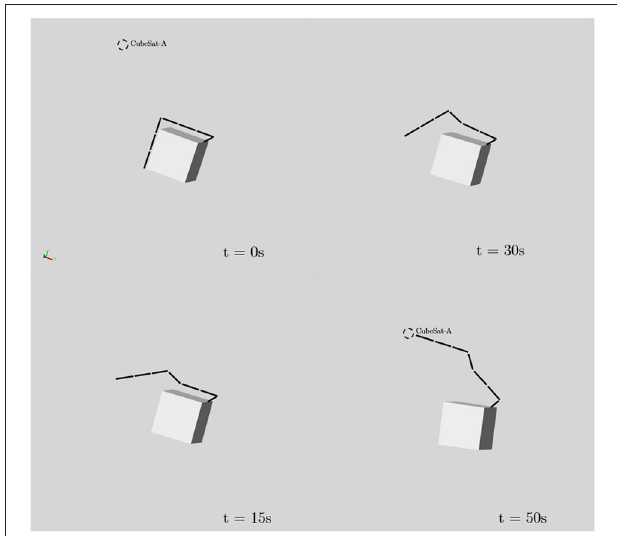
FIGURE 12 | Time series of the free-floating spacecraft reaching the CubeSat position with the trajectory sampled from learned probabilistic distribution. This trajectory has minimized impact to the attitude of the free-floating spacecraft.